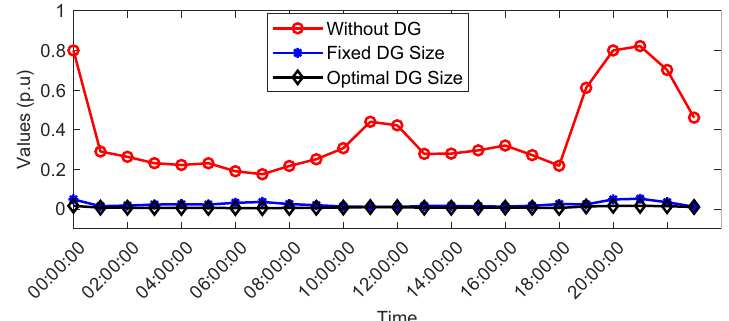
Fig. 6 The estimated hourly voltage deviation for Tanzanian power system